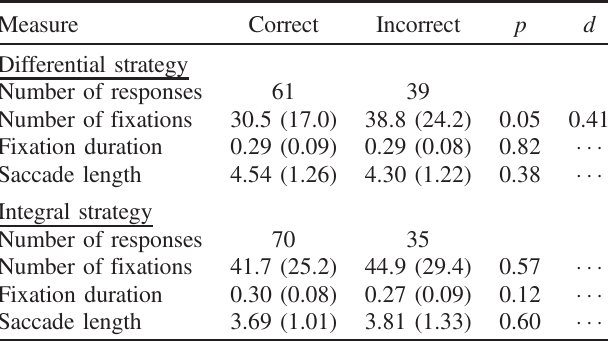
TABLE IV. Comparison of classical eye-tracking measures between correct and incorrect responses for each strategy. Measure